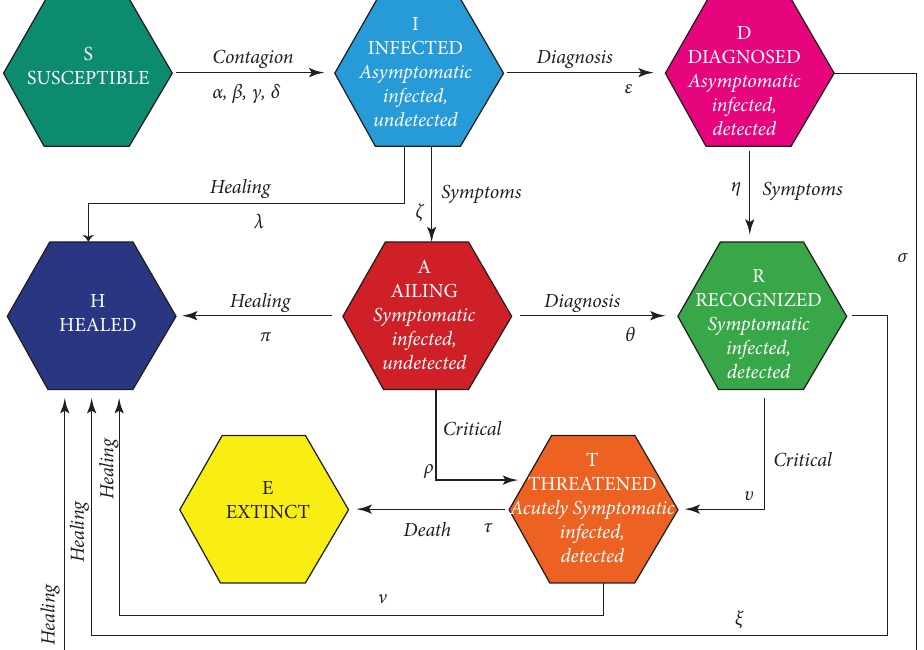
Figure 3: Graphical representation of the SIDARTHE compartmental.